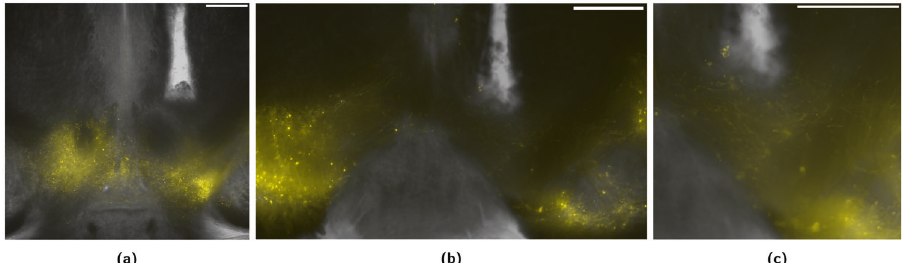
Fig. 5 Fiber implantation causes strong local cell displacement in the VTA. Depicted are YFP (coexpressed with Channelrhodopsin) fl uorescent microscopy images of the VTA, overlaid on corresponding transmission microscopy images of the same focal plane. All slices are seen in neurological orientation (the right of the image corresponds to the right of the animal). A higher magni fi cation of b is depicted in c . White bars indicate a scale of 500 µm, and slices are shown in neurological orientation. a 3.05 mm caudal of Bregma. b 3.5 mm caudal of Bregma. c 3.5 mm caudal of